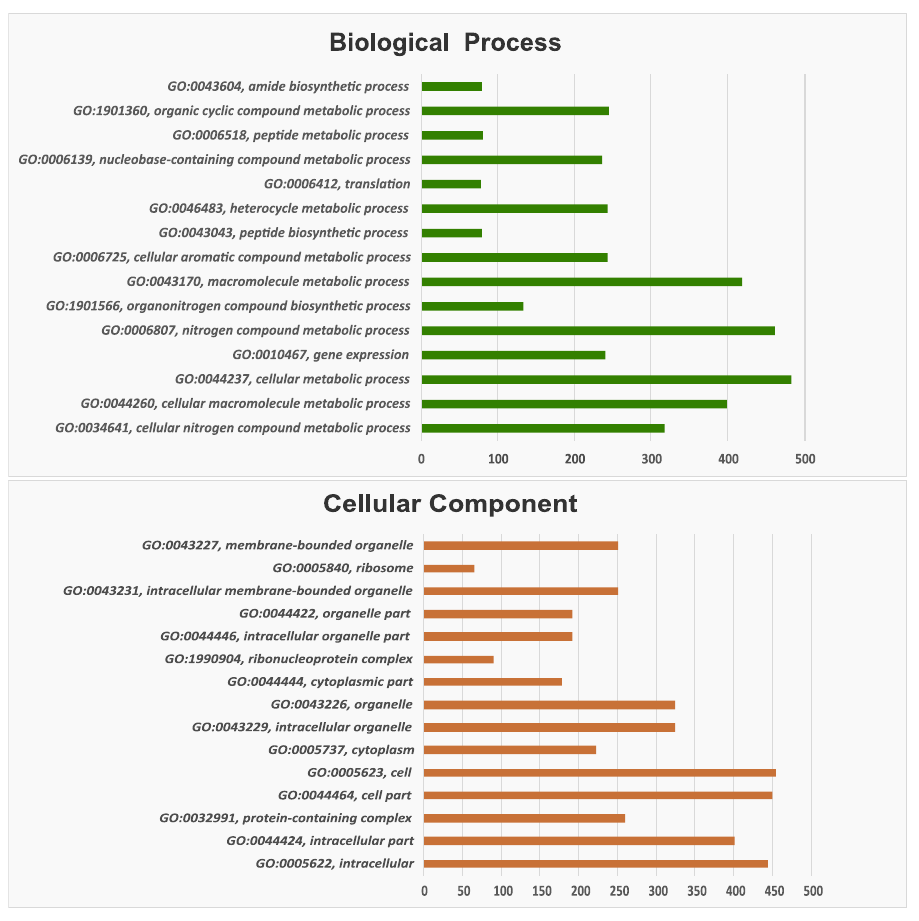
Figure 2. Bar graph of Gene Ontology (GO) enrichment analysis of the common transcripts across the six developmental stages. Upper: GO category "Biological process", lower: "Cellular component". X-axis: number of transcripts involved in the distinct GO terms. Y-axis: description of GO terms with the GO